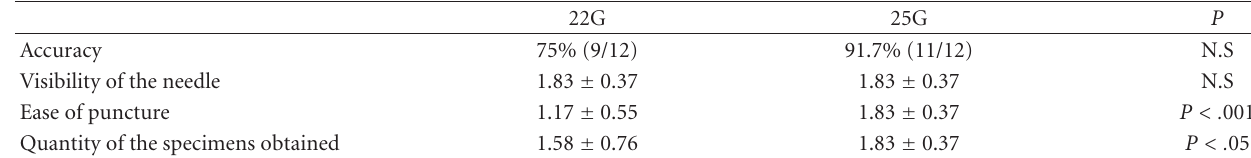
Table 5: Comparison of EUS-FNA of pancreatic masses with the 22-gauge and 25-gauge